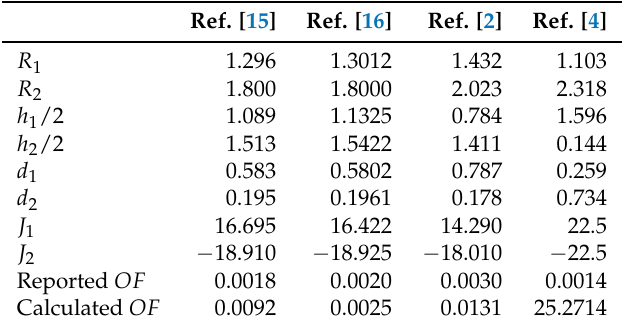
Table 5. Comparison of optima reported on other research